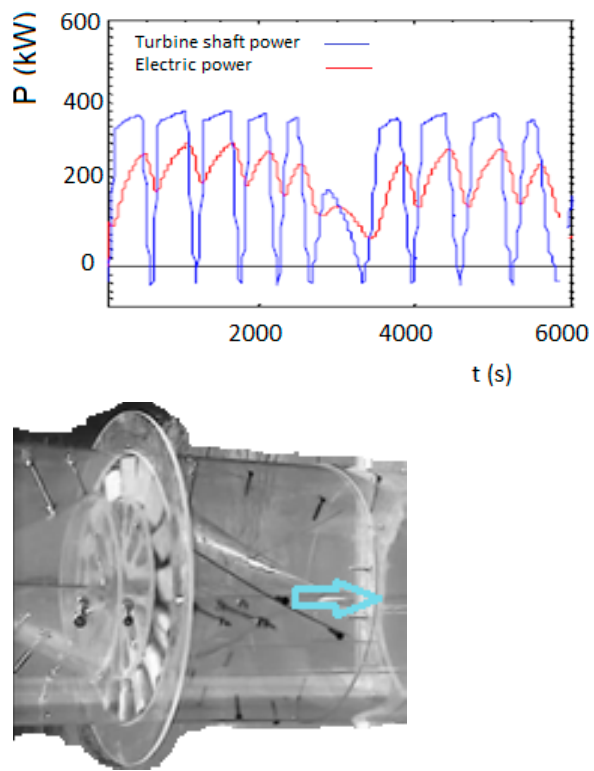
Figure 11. Instantaneous turbine shaft power and electric power for a Wells turbine for Hs = 2.9 m and D = 2 m.